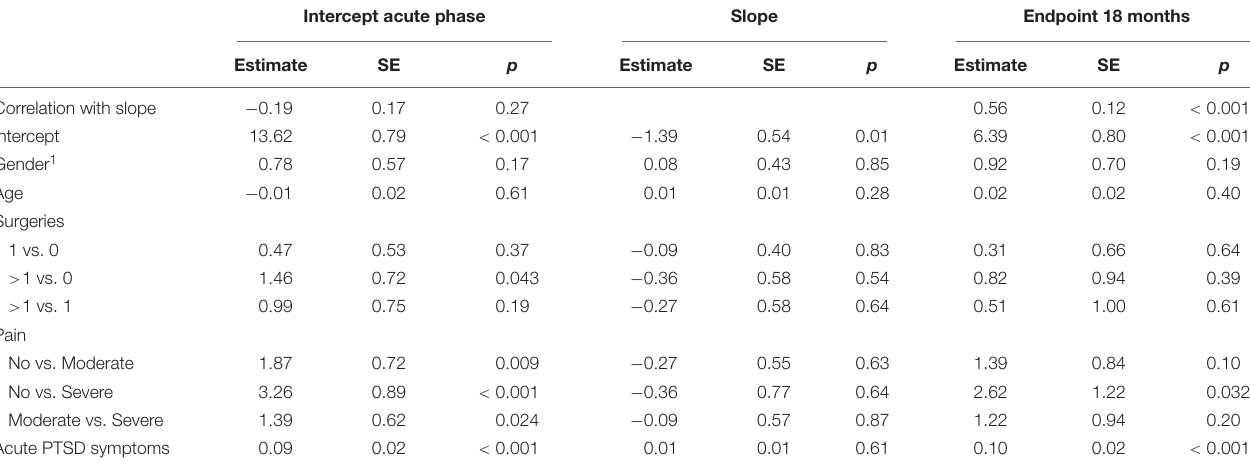
TABLE 3 | Linear growth over time: predictors of general fatigue ( N =